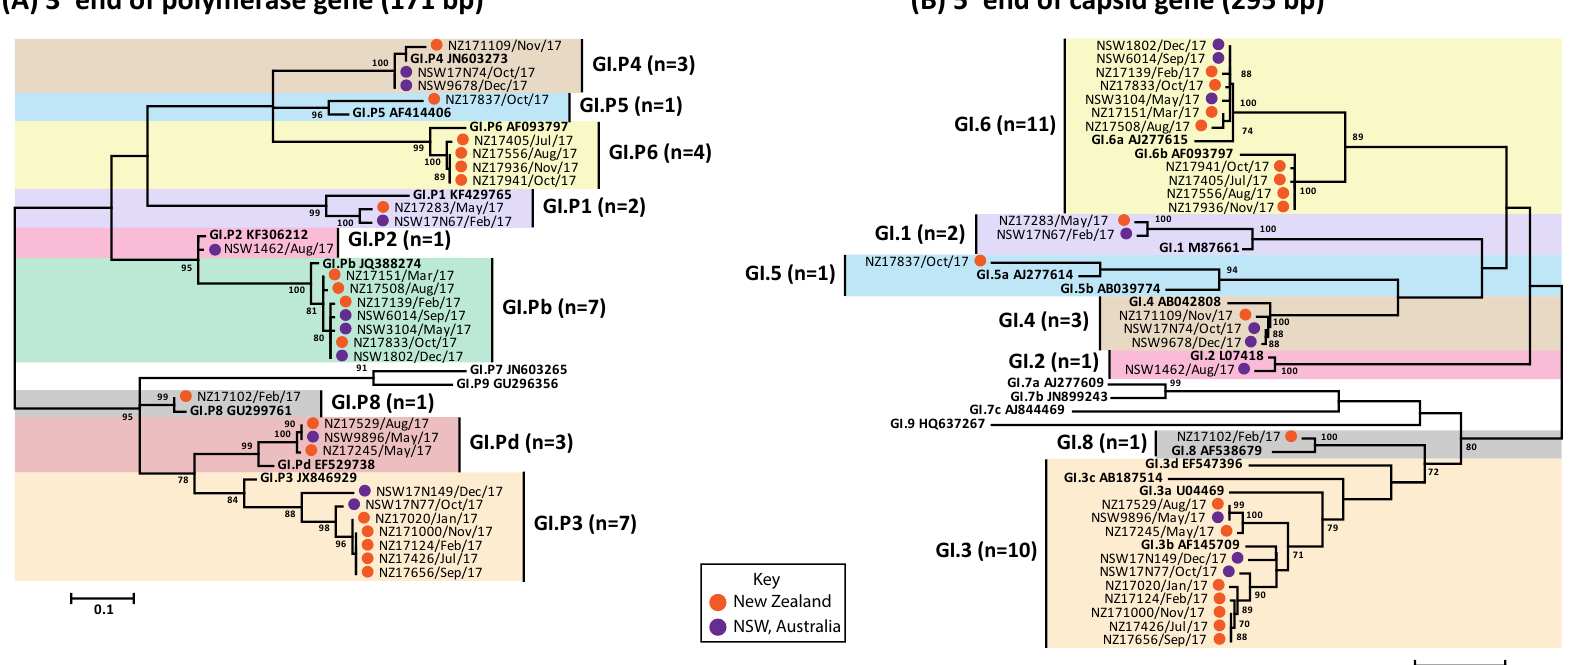
Figure 2. Phylogenetic analysis of polymerase (RdRp) and capsid (VP1) regions of GI noroviruses. Representative norovirus GI strains isolated in this study ( n = 29), from both NSW, Australia and New Zealand, are shown in this phylogenetic analysis. They are denoted with a colored bullet ( • ), where Australian samples are represented in purple and New Zealand samples in orange. All samples are labelled with their geographical location and time of strain isolation. Reference strains were obtained from the GenBank database, labelled with their genotype and accession number. ( A ) Maximum likelihood phylogeny derived from partial 3 (cid:48) end of polymerase gene (171 bp) of GI noroviruses. ( B ). Maximum phylogeny derived from partial 5 (cid:48) end of capsid gene (295 bp) of GI noroviruses. Sequence alignments were performed with MUSCLE algorithm. Maximum likelihood phylogenetic trees were produced using MEGA 5 software (https://www.megasoftware.net/) with bootstrapping test of 1000 replicates, based on the Kimura 2-parameter model. The bootstrap percentage values are shown at each branch point for values ≥ 70%. The number of substitutions per site is indicated by the scale